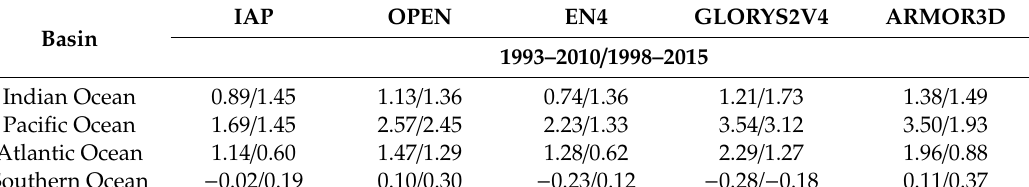
Table 3. Warming rates of OHC300 for di ff erent ocean basins in × 10 22 J / decade.